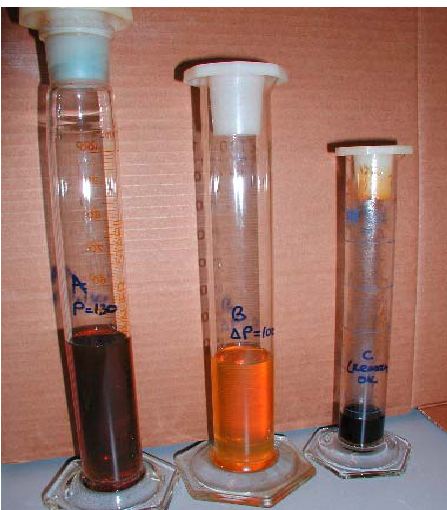
Figure 5. Asphaltene precipitation (wt %) at 100 °C with visual illustration on the influence of pressure drop on asphaltene precipitation. (a) Pressure drop of 20 bar; (b) Pressure drop of 100 bar; (c) Initial oil (model